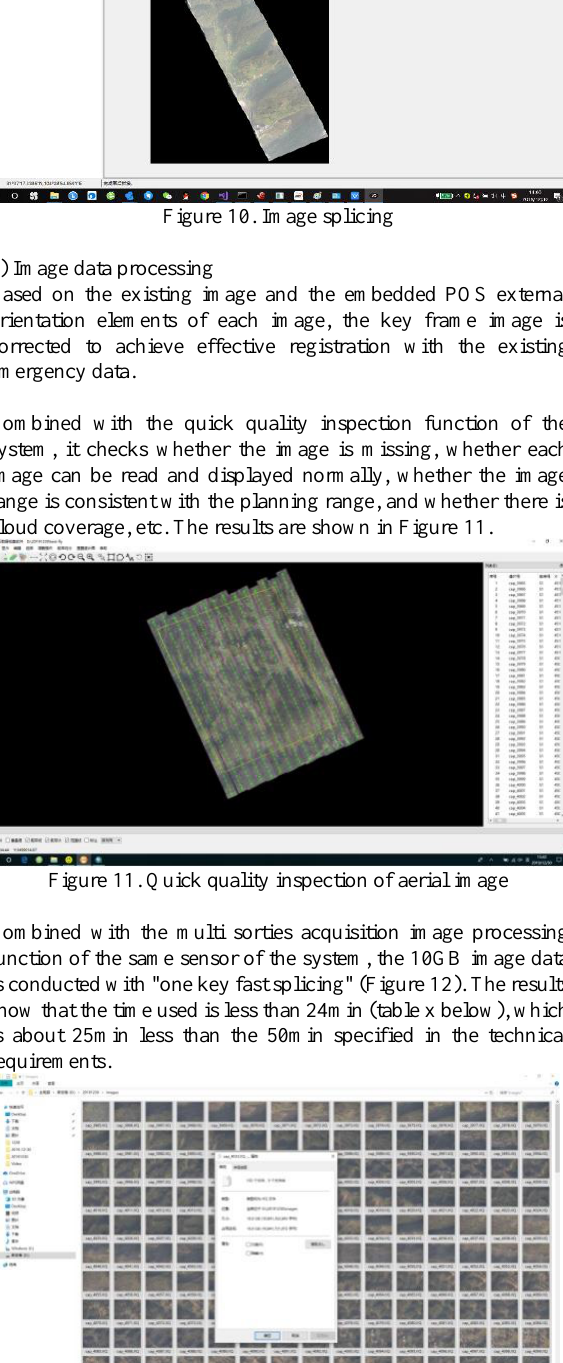
Figure 12. Image processing of 10GB